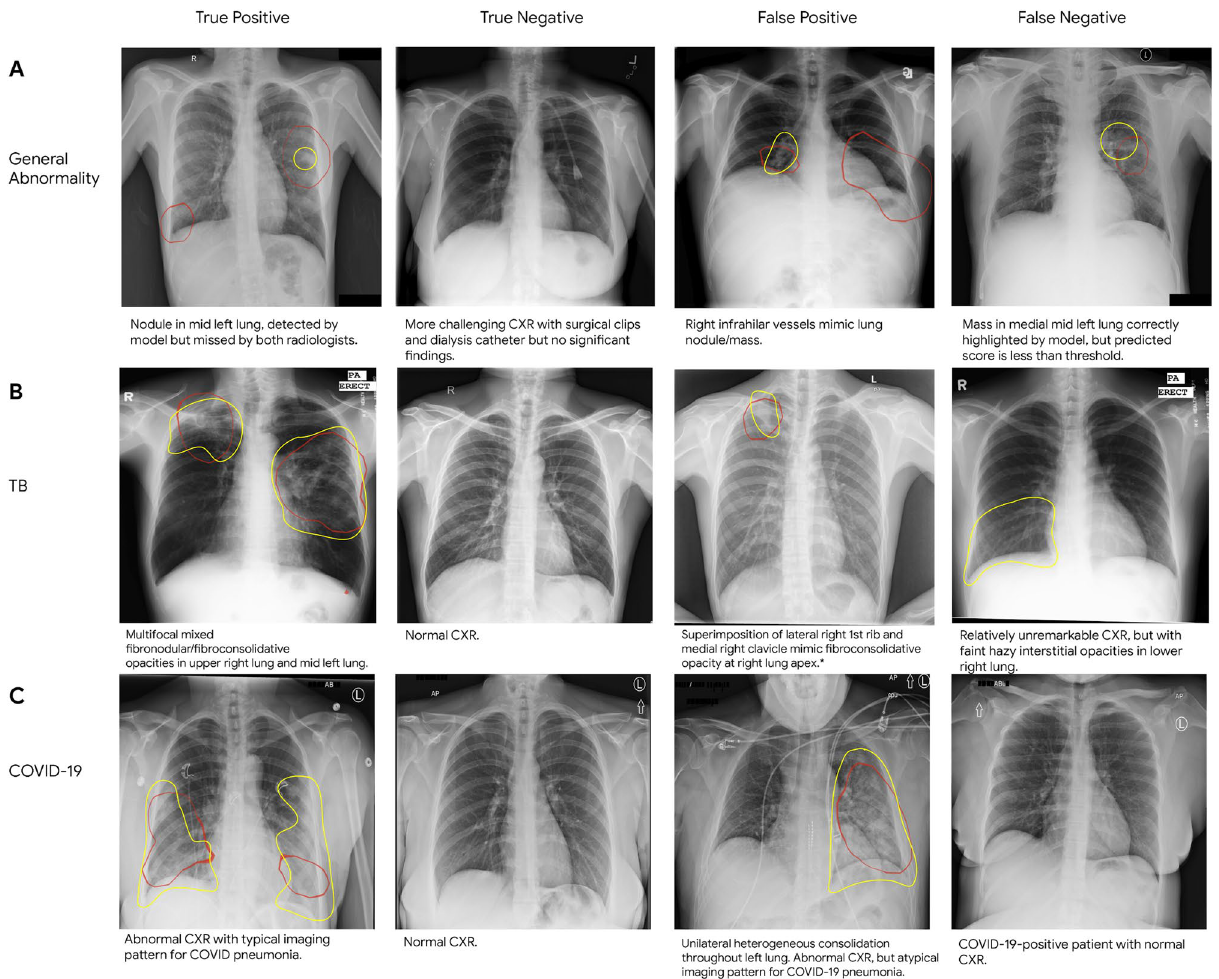
Figure 5. Sample CXRs of true and false positives, and true and false negatives for ( A ) general abnormalities, ( B ) TB, and ( C ) COVID-19. Each image has the class activation map presented as red outlines that indicate the areas the DLS is focusing on for identifying abnormalities, and yellow outlines representing regions of interest indicated by radiologists. Text descriptions for each CXR are below the respective image. Note that the general abnormality false negative example is shown with abnormal class activation maps. However, the DLS predictive score on the case was lower than the selected threshold; hence the image was classified as “normal”. Note that the TB false positive image was saved in the system with inverted colors that were inconsistent with what was specified in the DICOM header tag, and presented to the model that can present with a normal CXR 15 , which would also contribute to a lower observed AUC. Lastly, we expect an improved performance by training the model specifically on a COVID-19 dataset for detecting the disease, and future work is needed to investigate using the current general abnormality model as a pretraining step (i.e. to pre-initialize new networks) for other specific tasks 16 . However, we focused on evaluating a general-abnormal DLS’s performance in identifying patients with normal CXRs in a challenging COVID-19 cohort dataset. In this study, we focused on evaluating the generalizability of the DLS to unseen diseases (TB and COVID) rather than unseen CXR imaging features, in order to assess the clinical relevance of the DLS. Studies have suggested that radiologists’ ability to recognize abnormal imaging features of disease (e.g. consolidation or pleural effusion) on CXR appear relatively independent of experience level, from junior residents through senior faculty 17 . However, proficiency at accurately diagnosing disease on CXR remains strongly tied to experience level 18 . This disparity highlights the value in characterizing an AI system’s ability to detect disease on CXR, in addition to its ability to detect abnormal imaging features. The variability in patient population and clinical environment across different datasets also meant that the same operating point was unlikely to be appropriate across all settings. For example, a general outpatient setting is substantially less likely to contain CXR findings compared to a cohort of patients with respiratory symptoms or fevers in the midst of the COVID-19 pandemic. Similarly, datasets that are deliberately enriched for specific conditions (CXR-14 and TB) are skewed and are not representative of a general disease screening population. Thus, we used a small number of cases (n = 200) from each setting to determine the operating points specific to that setting. Consistent with this hypothesis, these operating points then generalized well to another dataset,